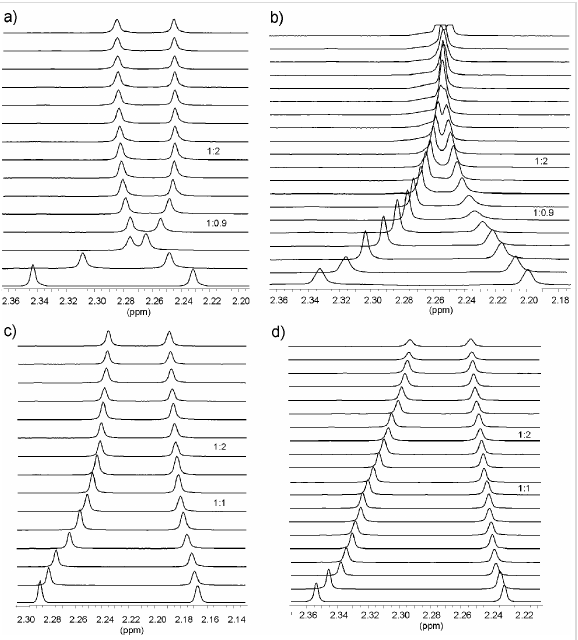
Figure 5: Partial 1 H NMR spectra (400 MHz; CDCl 3 ) of receptor 4 (a), 5 (b), 1 (c), and 3 (d) before (bottom) and after the addition of β-galactoside 8a . Shown are chemical shifts of the pyridine CH 3 reson- ances of the corresponding receptor. [ 4 ] = 0.89 mM, equiv of 8a : 0.00–4.65; [ 5 ] = 0.90 mM, equiv of 8a : 00–4.52; [ 1 ] = 0.95 mM, equiv of 8a : 0.00–4.26; [ 3 ] = 0.90 mM, equiv of 8a : 0.00–5.20.